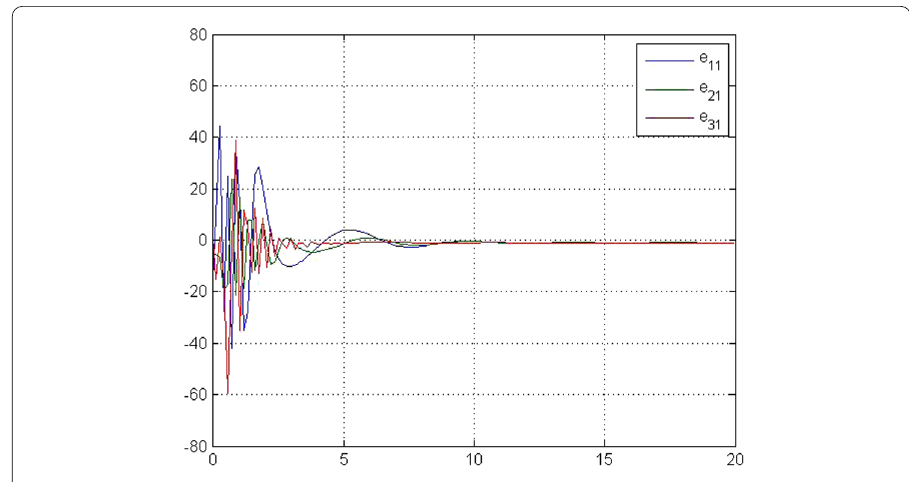
Figure 1 The state estimation error trajectories e ki ( t ) ( k = 1,2,3) ( i = 1)